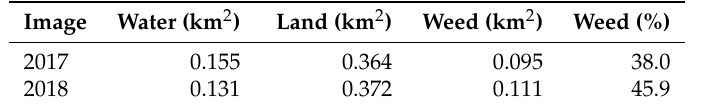
Table 10. Classificationareasinkm 2 , andproportionofweedinthechannels,